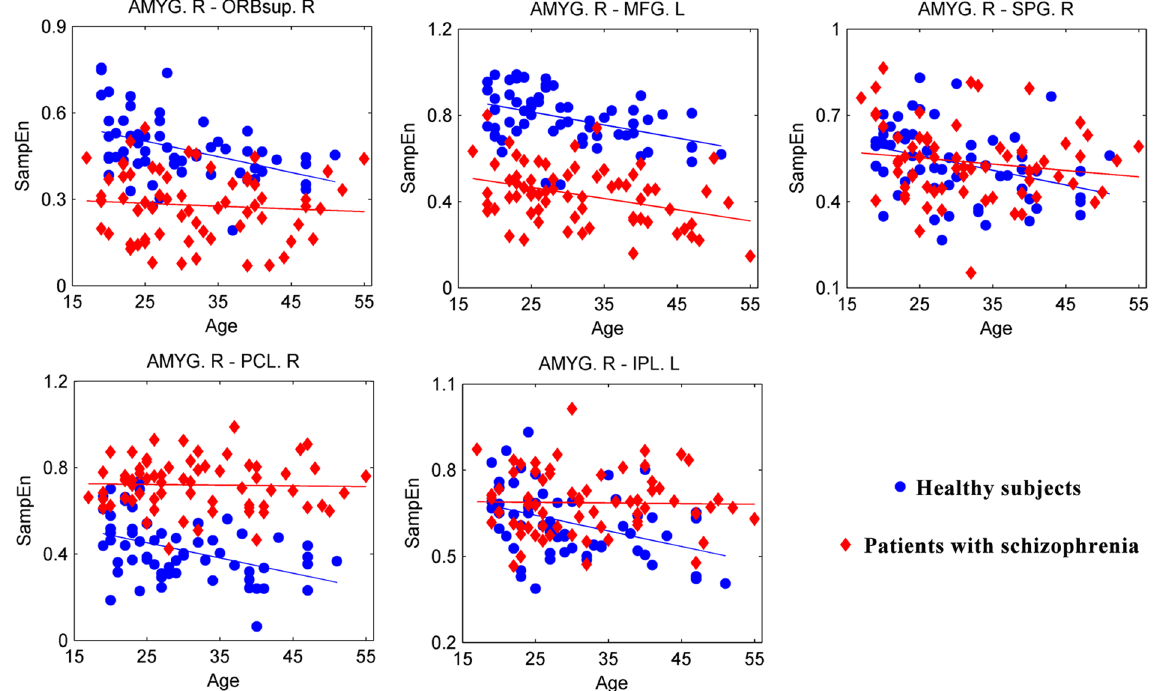
Figure 4. Associations between age and SampEn of functional connections in healthy subjects and patients with schizophrenia. AMYG, amygdala; ORBsup, superior orbital frontal gyrus; MFG, middle frontal gyrus; SPG, superior parietal gyrus; PCL, paracentral lobule; IPL, inferior parietal gyrus; L, left; R, right.